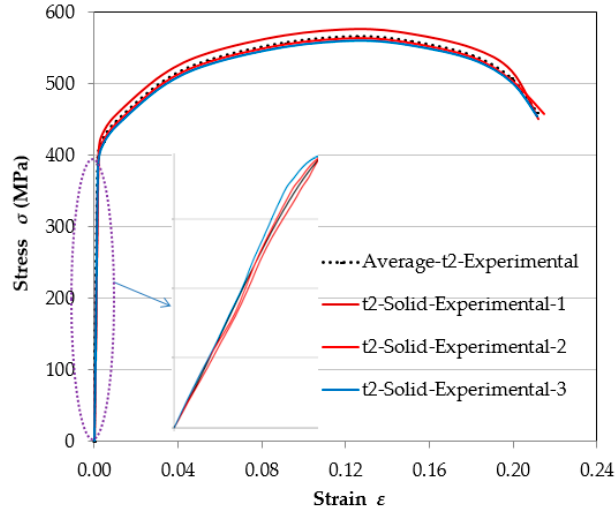
Figure 5. Experimental engineering stress-strain relationships. Table 2. Comparison of proportional limit and ultimate strength ratios for experimental and FE results.